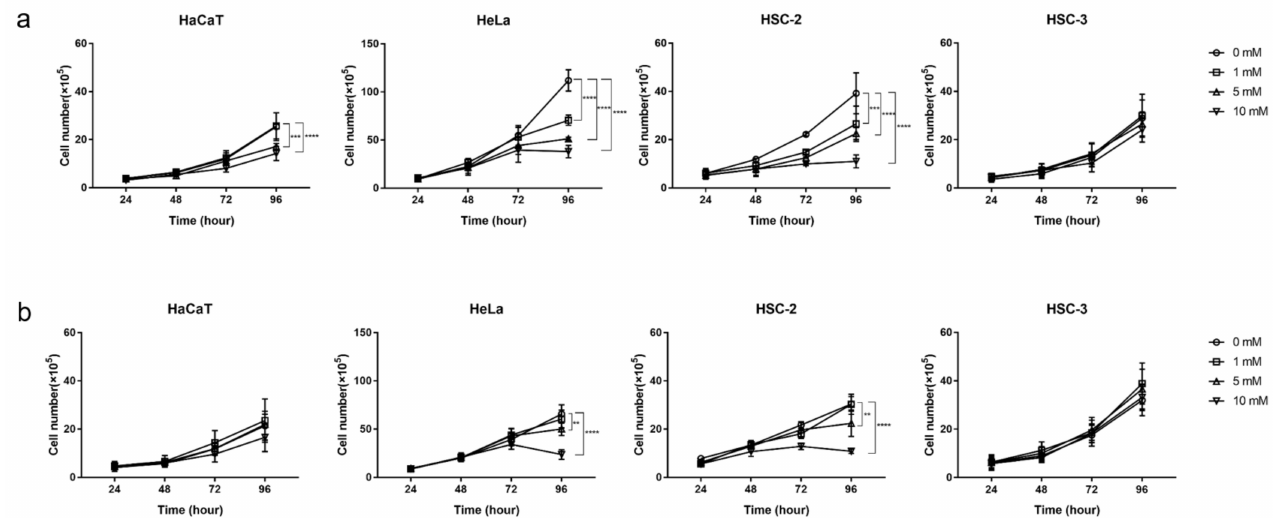
Figure 1. Time- and dose-dependent effects of metformin on cell growth. ( a ) Cells were cultured under normoxic conditions. ( b ) Cells were cultured under hypoxic conditions. A 2-way ANOVA and Tukey’s test. ** p < 0.01, *** p < 0.001, **** p < 0.0001. All experiments were independently performed in